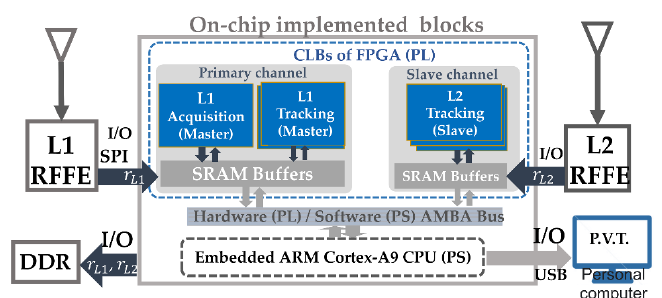
Figure 8. Hardware units of FPGA and implemented blocks.